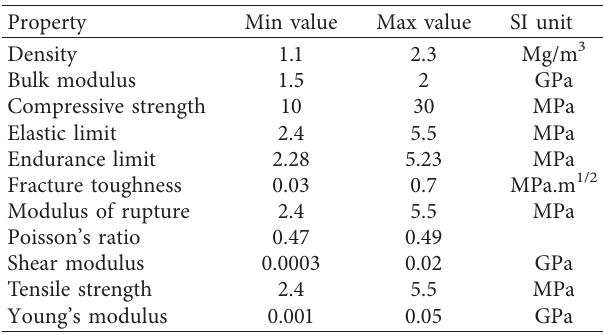
Table 1: Silicone rubber specifications.